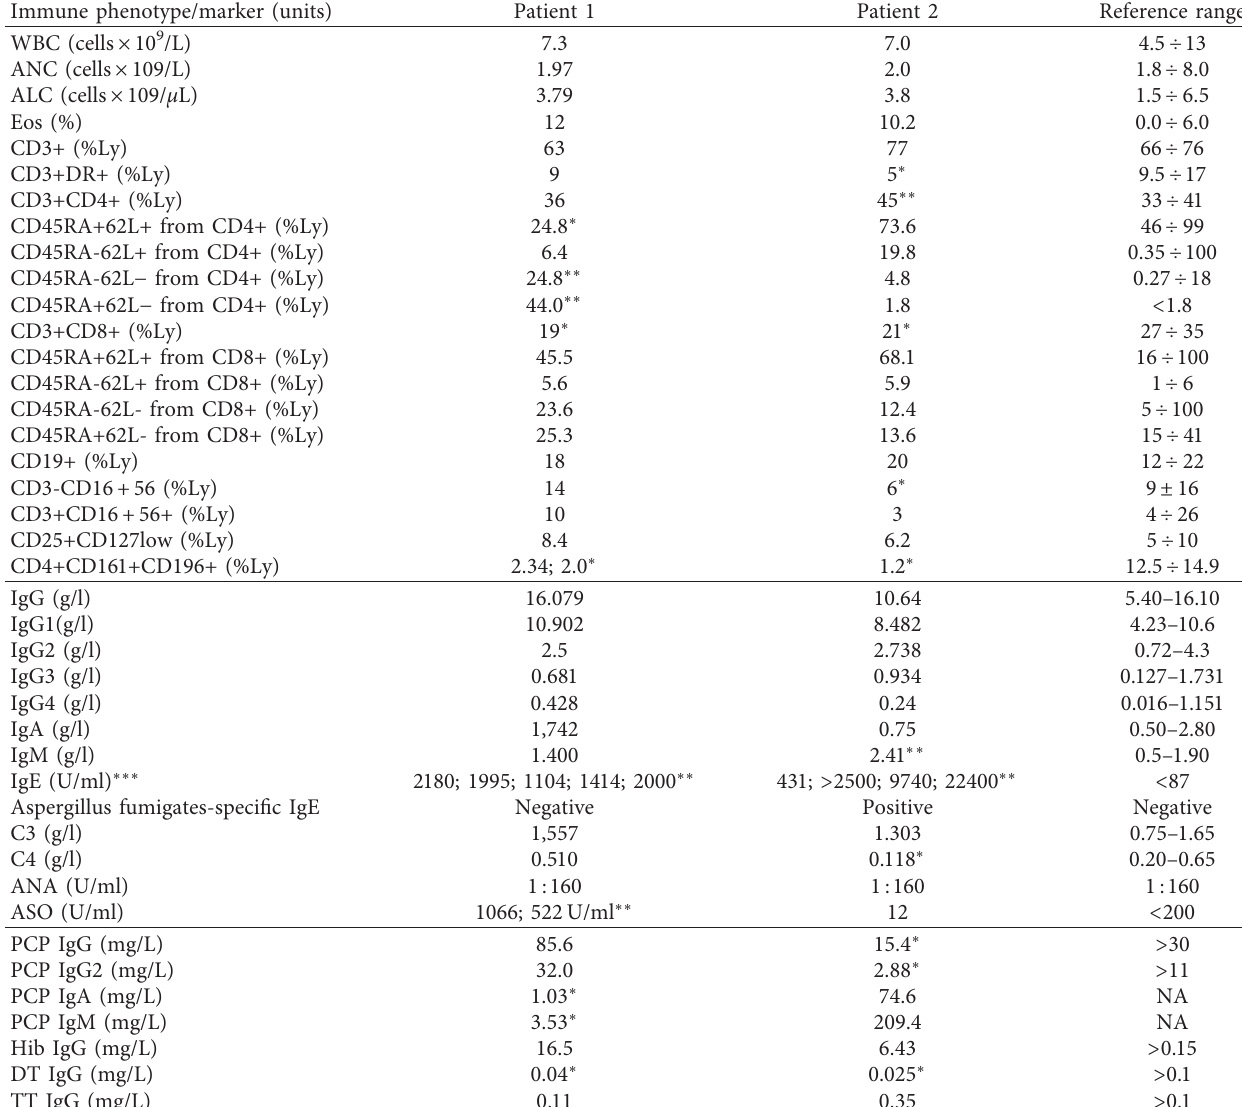
Table 3: Immunological phenotype of Patients 1 and